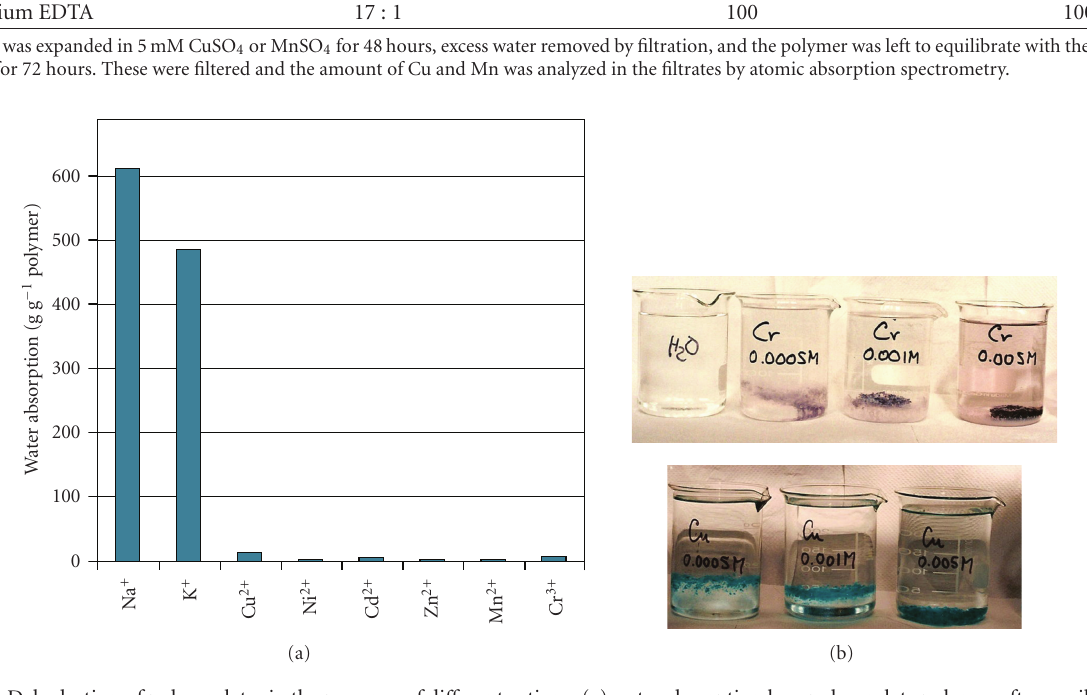
because of their relationship with soil biological processes and rapid response to changes [4, 41,